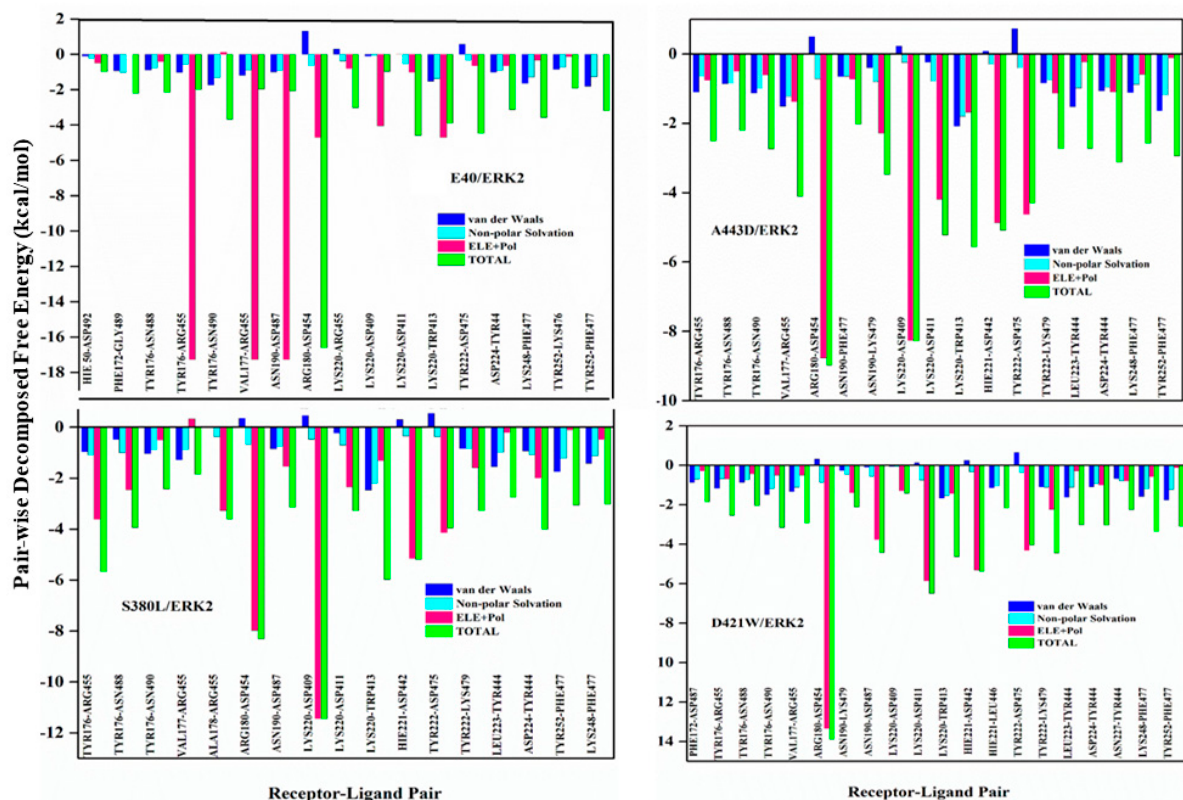
Figure 4. Comparison of pairwise decomposition free energy of complexes. Clockwise: E40/ERK2, A443D/ERK2, D421W/ERK2, and S380L/ERK2. Residues of receptor-ligand pairs and decomposition free energies in kcal/mol are shown on the X and Y axes, respectively. Contributions of van der Waals, non-polar solvation, polar, and total energies are shown with different colour bars.